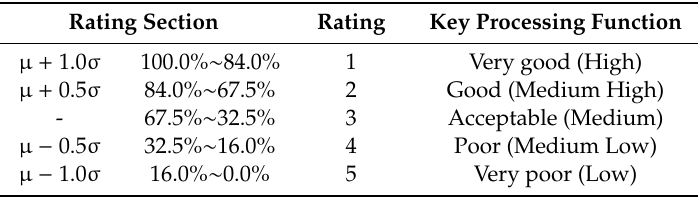
Table 5. The rating section by the standard deviation.